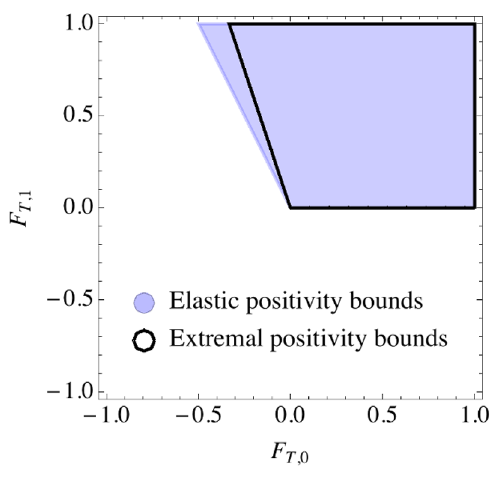
Figure 1 . A comparison of elastic positivity bounds and extremal positivity bounds on the F T, 0 - F T, 1 plane. All other coefficients are fixed to